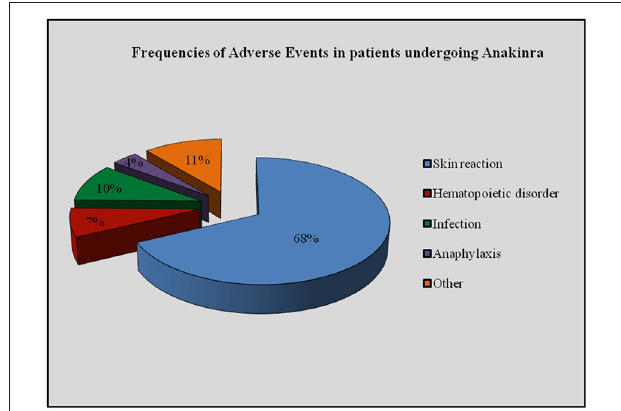
FIGURE 8 | Frequency of adverse events in patients undergoing Anakinra.